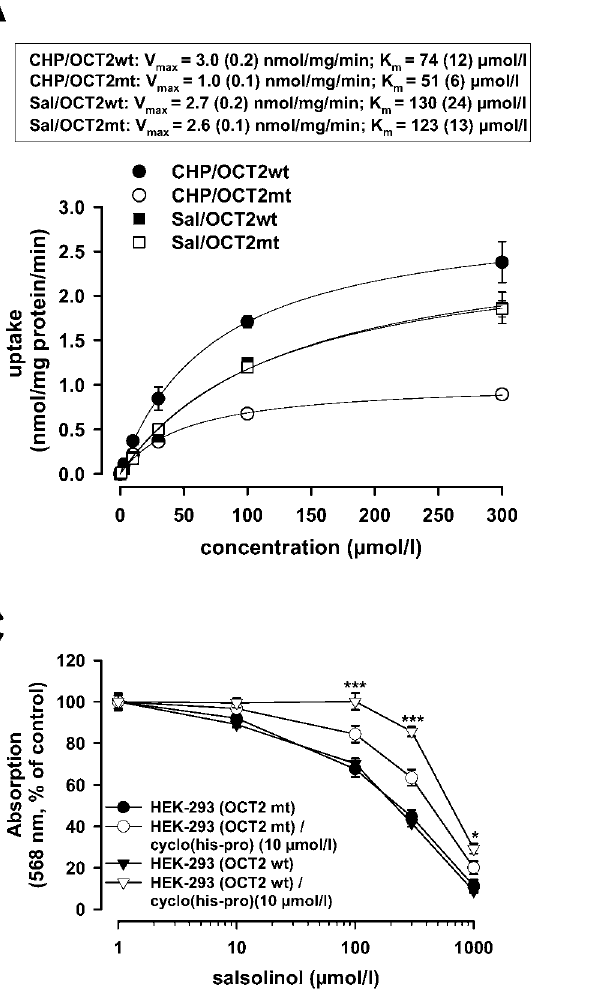
Figure 5. Impact of the R400C polymorphism of OCT2 on transport kinetics. (A) Concentration dependence, maximal transport rate V max , and Michaelis-Menten constant K m of specific uptake of cyclo(his-pro) or salsolinol into HEK-293 cells transfected with wild-type (wt) 400R or mutant (mt) 400C variant after 1 min of loading (n=3, mean 6 s.e.m). (B) Time dependence and influx clearance Cl in of specific uptake after incubation with 10 m mol/l of cyclo(his-pro) or salsolinol (n=3, mean 6 s.e.m). For cyclo(his-pro), transport efficiency (V max /K m ) and clearance of 400C were lower, achieving 48% (P=0.0017) and 70% (P=0.002) of the 400R reference respectively. For salsolinol, transport efficiency and clearance showed no significant differences between 400R and 400C (P=0.995 and 0.591 respectively). (C) Viability of HEK-293 cells expressing the OCT2 wild-type 400R or mutant 400C variant was assessed by MTT reduction assay after 48 h exposure to different concentrations of salsolinol following 12 h of incubation with cyclo(his-pro) (10 m mol/l). The 400C variant was less protected by cyclo(his-pro) against salsolinol-induced cell loss with an EC 50 (95% confidence interval) of 406 (321 to 513) m mol/l compared to 763 (655 to 889) m mol/l (P , 0.001) for 400R (n=24–48; mean 6 s.e.m.; *P , 0.05, ***P , 0.001).